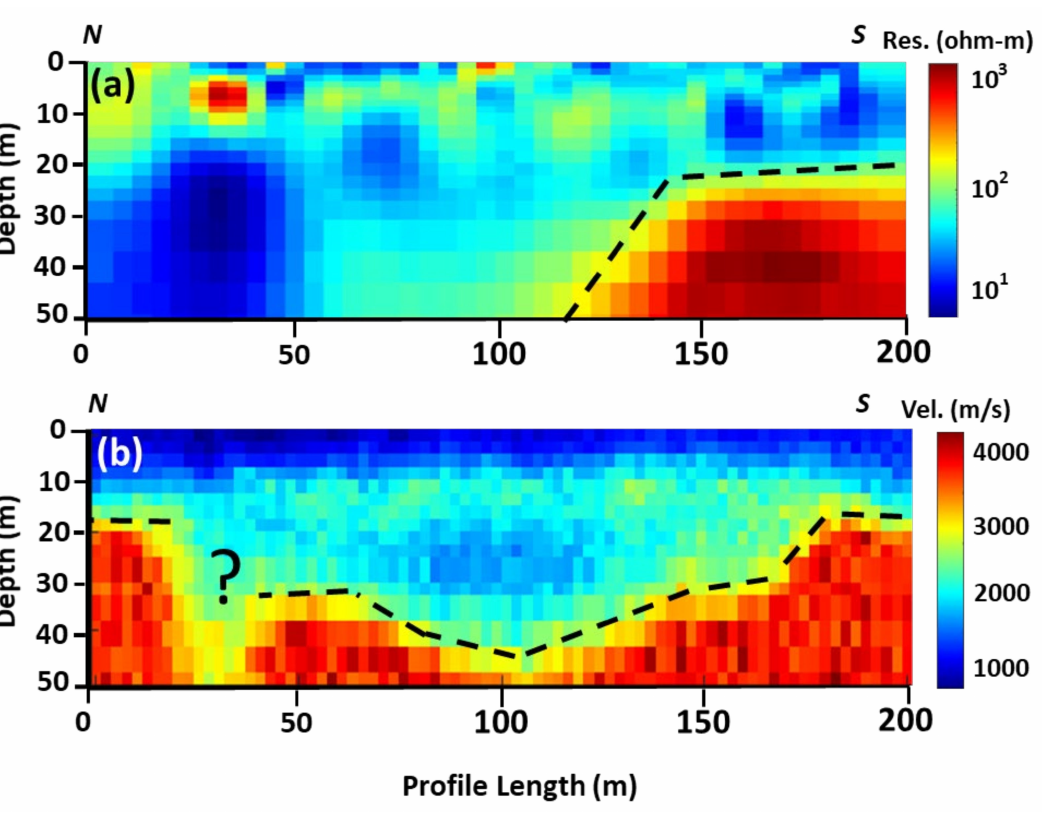
Figure 7. Structural interpretation of the resistivity and velocity models from profile 2 ( a ) interpreted resistivity model; and ( b ) interpreted velocity